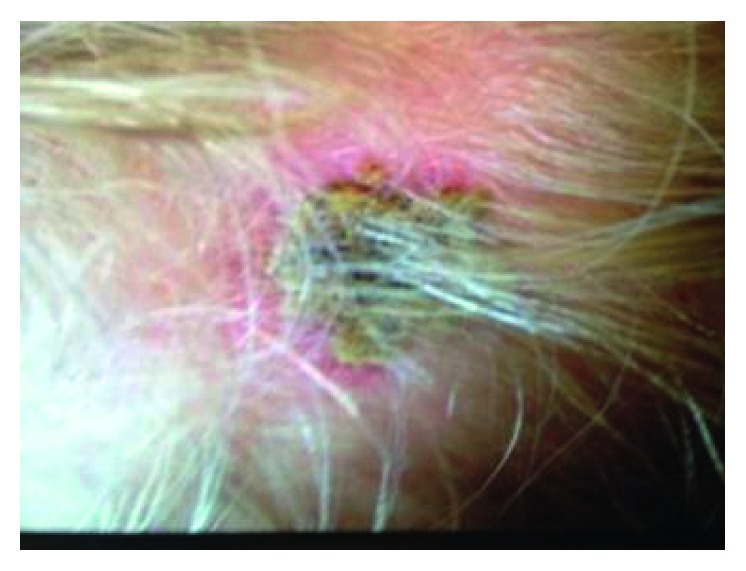
Scab on the skull.